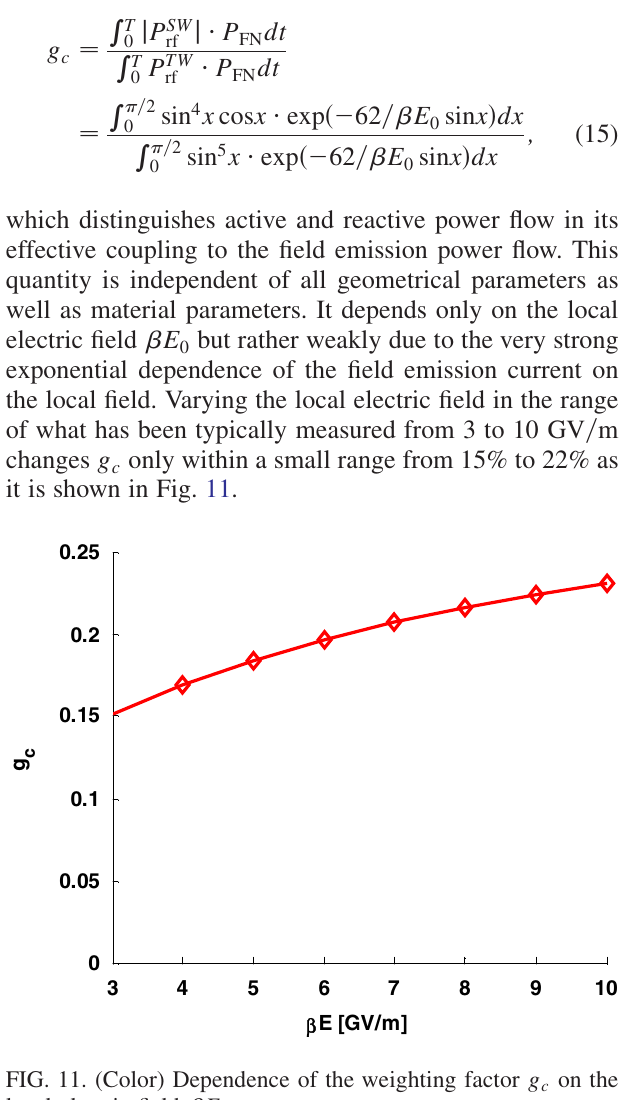
FIG. 12. (Color) Square root of S sented in Fig. 3.